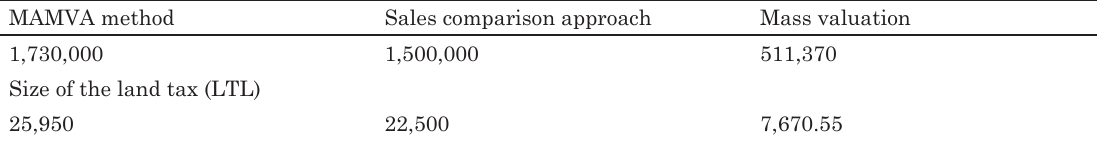
table 6. Comparison of the values of the site in Švitrigailos Street XX